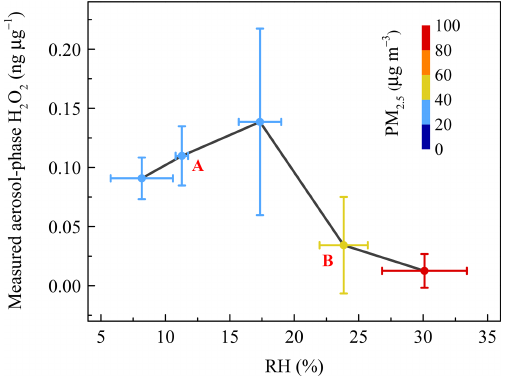
Figure 4. The relationship between measured aerosol-phase H 2 O 2 level and relative humidity (RH). Coloured circles denote the mass concentration of PM 2 . 5 . The vertical error bars represent the stan- dard deviations of aerosol-phase H 2 O 2 concentration in every RH range bin. A and B refer to the increase and decrease stages, respec-